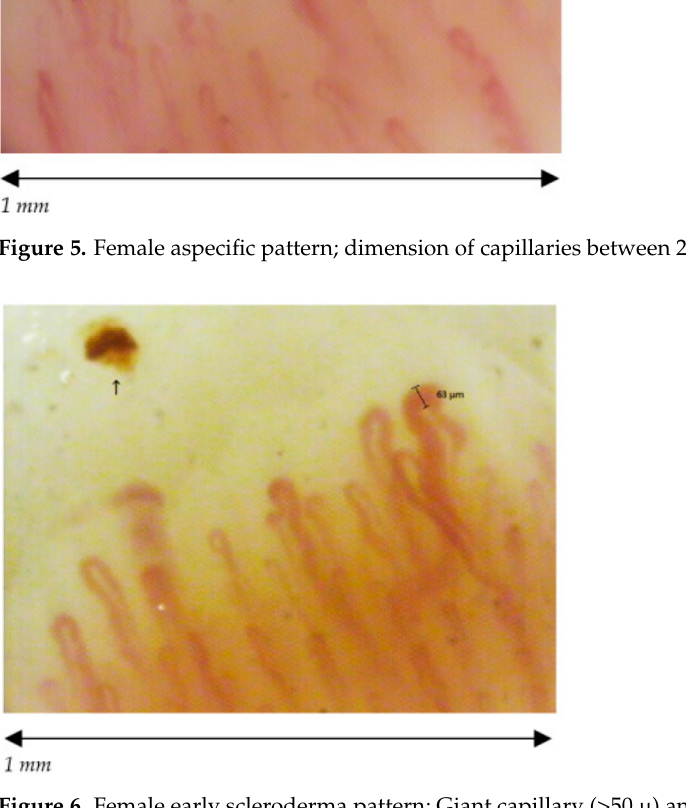
Figure 6. Female early scleroderma pattern; Giant capillary (>50 µ) and hemorrhage ( ↑ ).